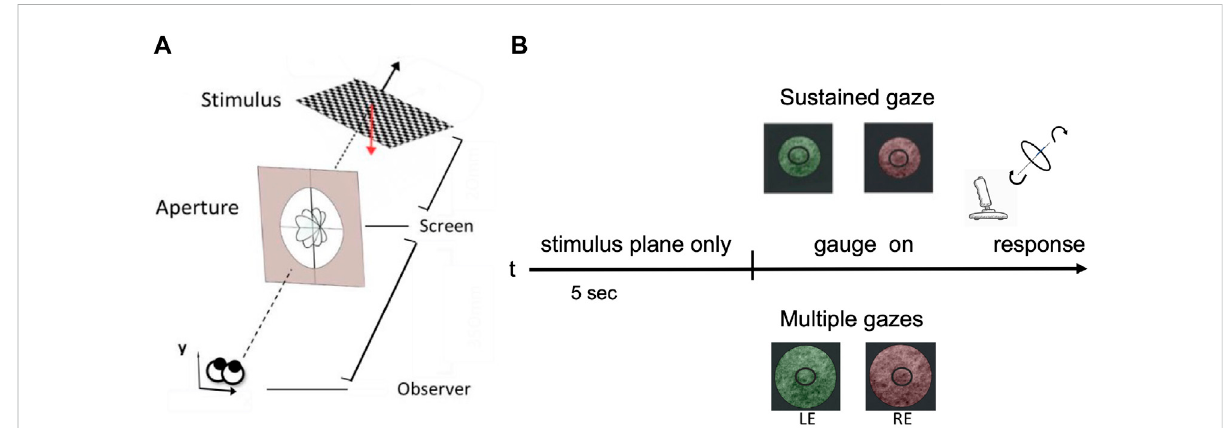
FIGURE 5 A schematic view of the human slant/tilt perceptual experiment. (A) Each 3D oriented plane is rendered stereoscopically. The observer adjusts theorientationofthegaugeringindepthuntilitappearslying fl atonthesurfaceoftheplanarstimulus. (B) Theexperimentalprotocol:forthe fi rst5 s participants were presented with a 3D rotated planar surface and were asked to either keep their gaze fi xed on a central dot - ‘ SG condition ’ - or activelyexplorethestimulus- ‘ MGcondition ’ .Thetwoconditionswerealsoparameterizedbytheaperturesize:smallone(121 mmofdiameter) for the SG and a wider one (242 mm of diameter) for the MG condition. Each stimulus is presented dichoptically in the left eye (LE) and in the right eye